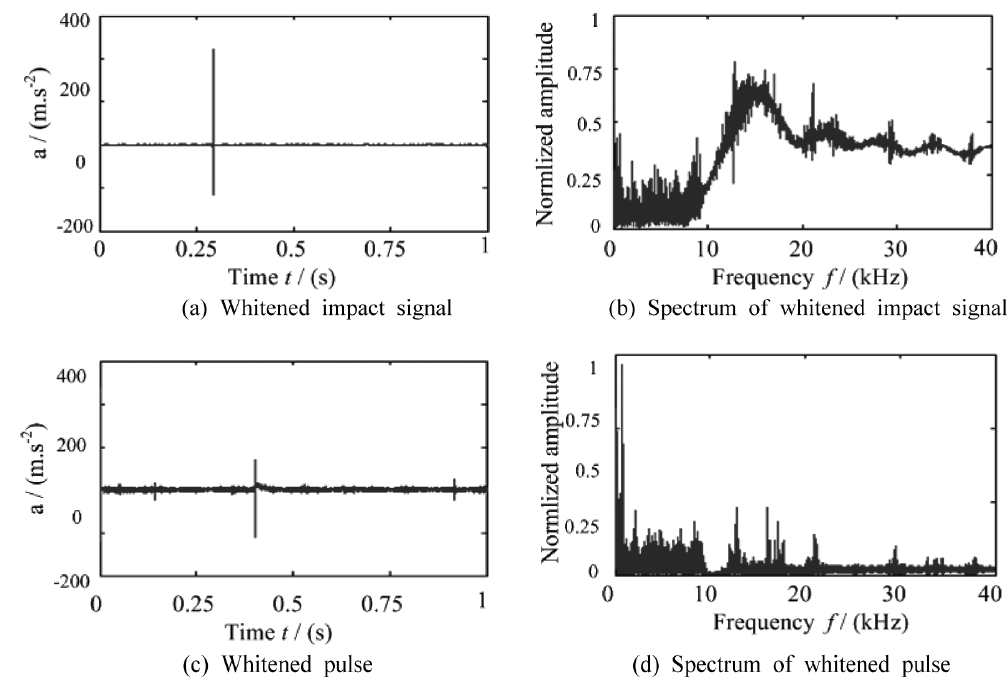
Fig. 7. Pulse signal with noise and its normalized spectrum after whitening ( − 10